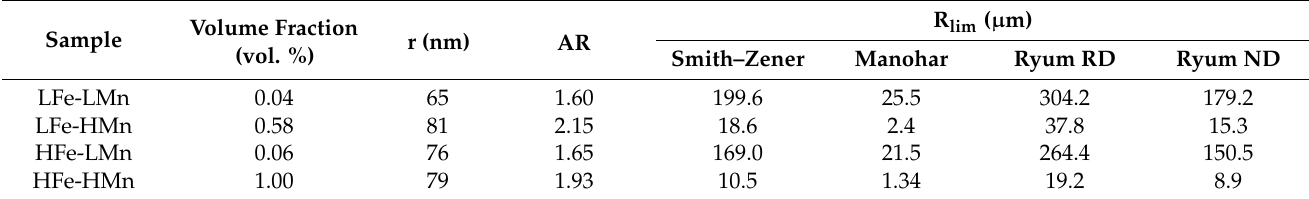
Table 5. Volume fractions and morphological parameters of the dispersoids for NR-C cast samples homogenized at 550 ◦ C, cold rolled to a CRD of 63% and soft annealed; limiting grain sizes calculated using the models of Smith–Zener [26], Manohar [33] and Ryum